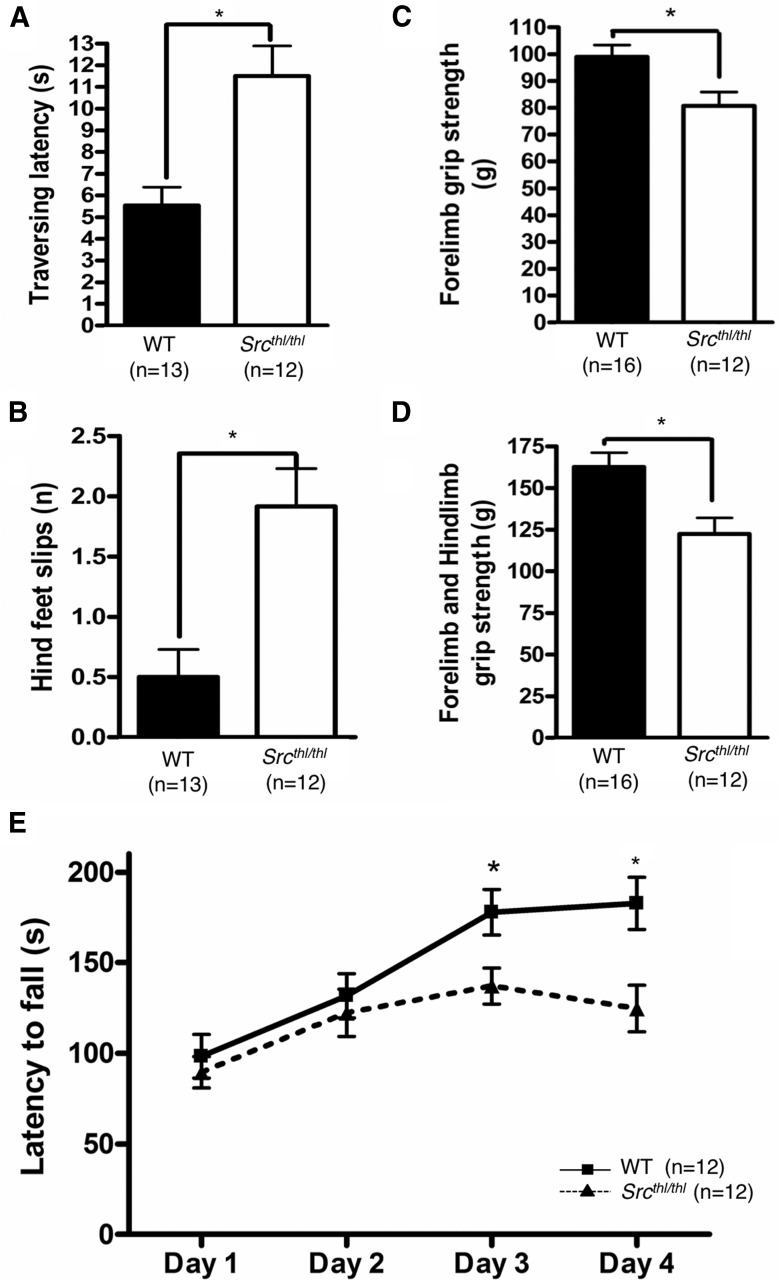
Balance and motor strength deficiency in Srcthl/thl mice and the inability to learn motor skills. Quantitative analysis of raised balance beam, grip strength, and rotarod task in WT and Srcthl/thl mice. A, Srcthl/thl mice needed significantly more time to cross the balance beam than did WT mice (n = 13 WT (7 males, 6 females), n = 12 Srcthl/thl (6 males, 6 females)). B, Srcthl/thl mice had significantly more hindfoot slips than did WT mice. C, Grip strength analysis revealed significantly reduced forelimb grip strength in Srcthl/thl mice compared with WT animals (n = 16 WT (9 males, 7 females), n = 12 Srcthl/thl (6 males, 6 females)). D, Grip strength analysis revealed significantly reduced combined forelimb and hindlimb grip strength in Srcthl/thl mice compared with WT animals (n = 16 WT (9 males, 7 females), n = 12 Srcthl/thl (6 males, 6 females)). E, Mice were tested on an accelerating rotarod with the same speed for 4 consecutive days. The latencies from rotation onset until the mice fell off the rod were measured. WT mice managed to stay significantly longer on the accelerating rotarod than Srcthl/thl mice on days 3 and 4. The falling latencies were similar in both groups on days 1 and 2. Falling latencies were compared within genotype between days 1 and 4 (n = 12 WT (6 males, 6 females), n = 12 Srcthl/thl (6 males, 6 females)). Data are presented as mean ± SEM. *p < 0.05.